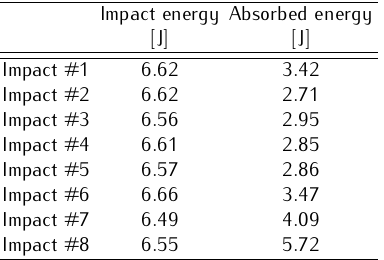
Table 1. Level of absorbed energy of the repeated impact